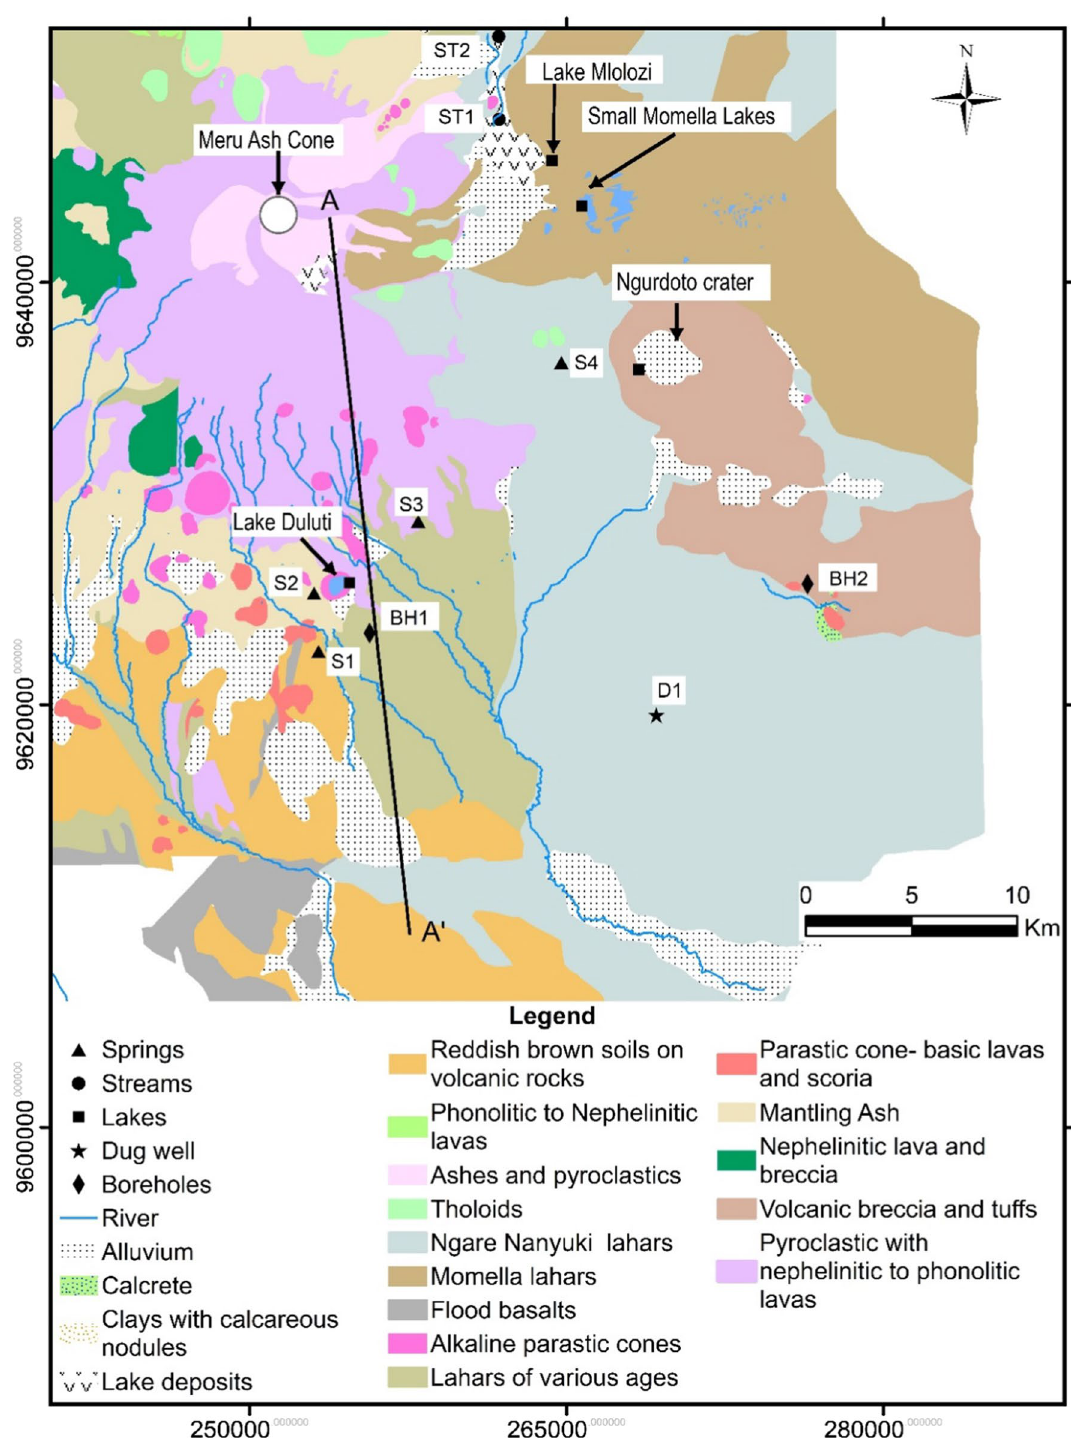
Fig. 2 Geological map (after Wilkinson et al. 1986) with key loca- tions of boreholes (BH1: Mandela, BH2: Lodhia), dug wells (D1: Maroroni), springs (S1: Nduruma, S2: Makisolo, S3: Makumira, the